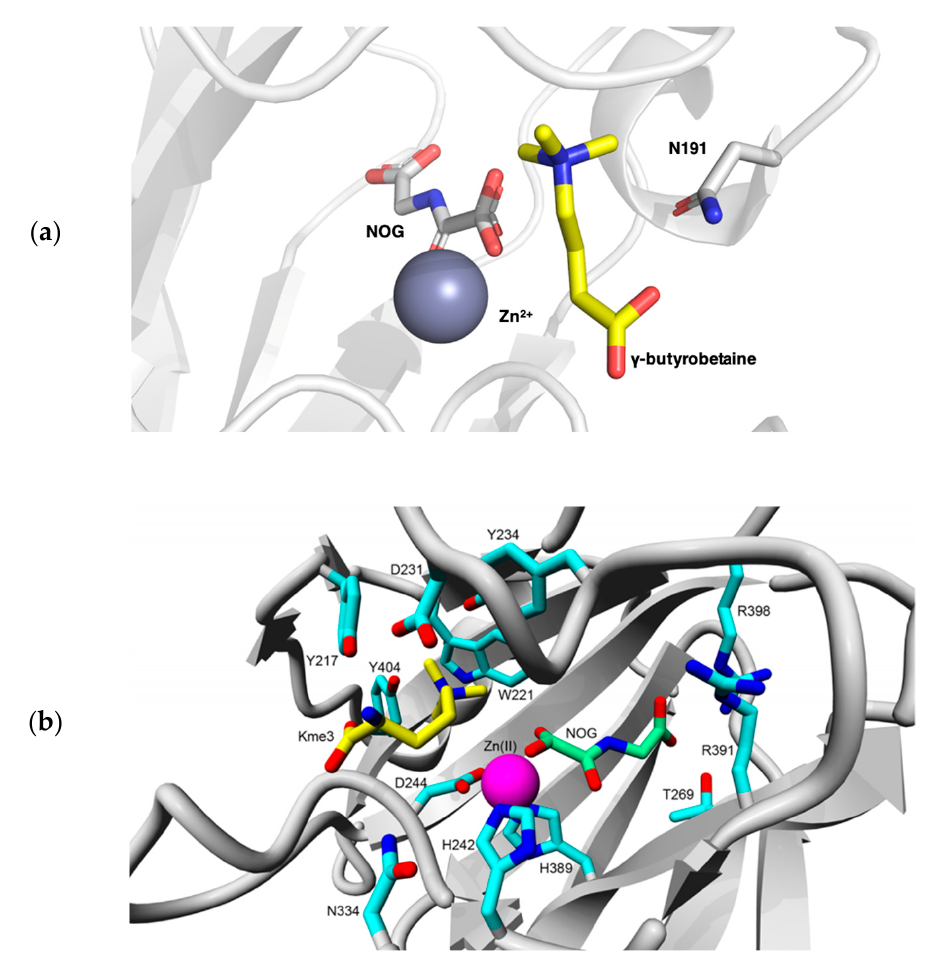
Figure 3. ( a ) Ribbon representations of BBOX (grey) in complex with γ -butyrobetaine (yellow) and NOG ( N -oxalylglycine, inactive 2OG analogue). Key active site residues are labeled and zinc ions are depicted as spheres (PDB-ID: 3O2G) [36]. ( b ) The computational homology model for N ε -trimethyllysine hydroxylase (TMLH), based on the crystal structure of BBOX in the presence of zinc (pink), NOG (green), and Kme3 (yellow). (Reprinted (adapted) with permission from Biochem. J. (2019) 476 (7): 1109–1119. Copyright 2020 Portland Press.).